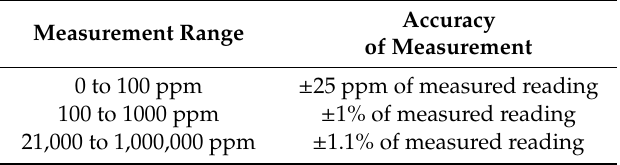
Table 1. Modelled methane gas sensitivity values for di ff erent concentration ranges.